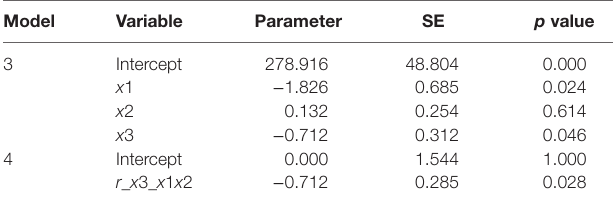
TABLe 7 | Comparison of regression coefficients in multiple regressions.